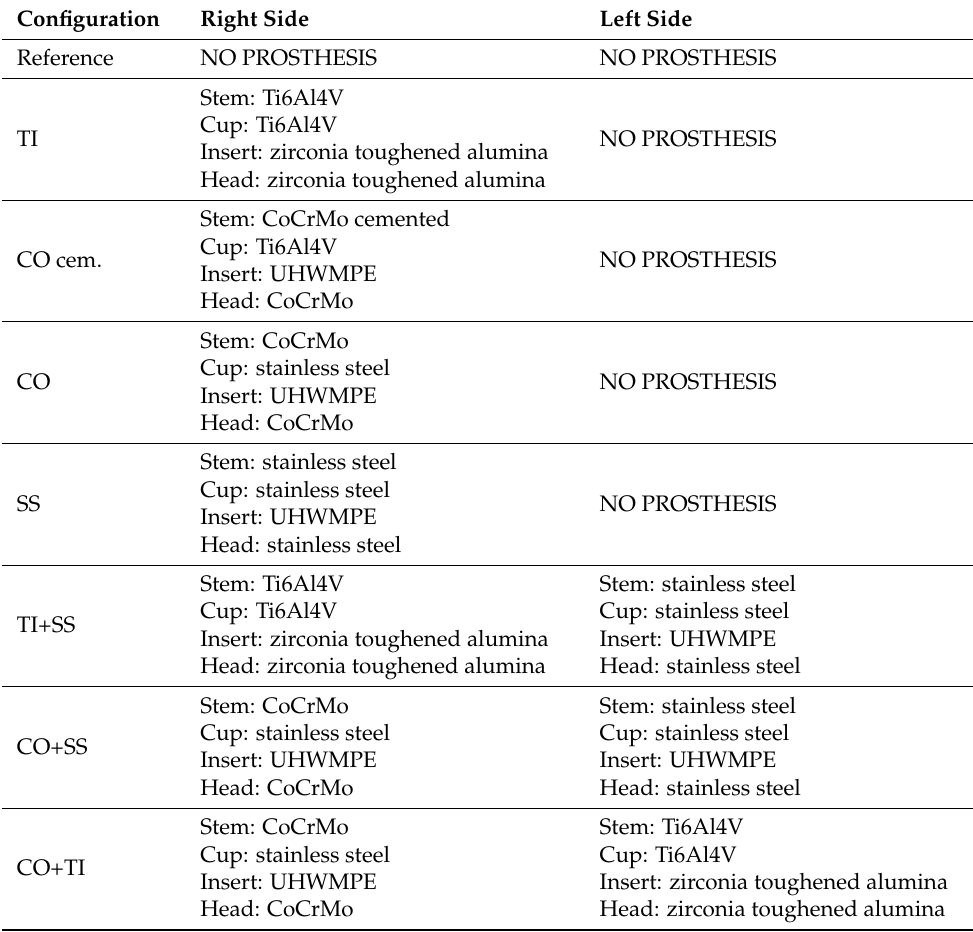
Table 1. Prosthetic materials for unilateral and bilateral configurations. The configuration name is determined by the stem’s